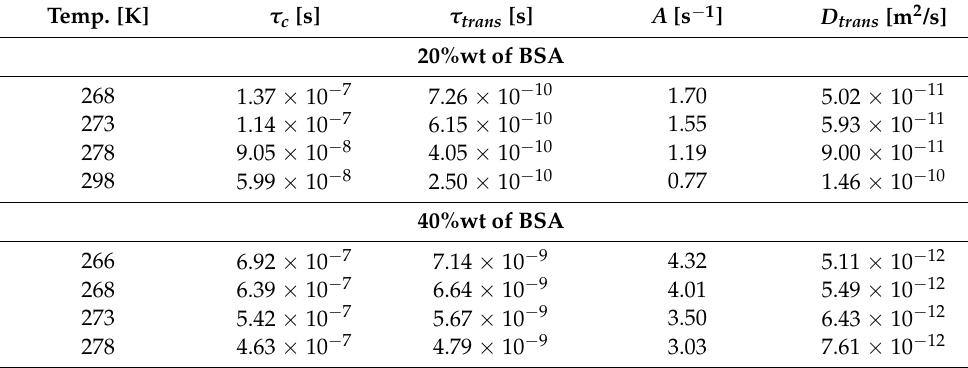
Table 3. Parameters obtained from the analysis of the 1 H spin-lattice relaxation data for BSA–water mixtures in terms of Equation (9). The dipolar relaxation constant, C DD , for 20% and 40%wt concen- tration of BSA yield: C DD = 9.81 × 10 6 Hz 2 and C DD = 8.28 × 10 6 Hz 2 , respectively, the relaxation constant associated with two dimensional translation diffusion is C trans = 7.09 × 10 7 Hz 2 for both concentrations of BSA. The translation diffusion coefficient has been obtained from the relationship: D trans = d 2 2 τ trans